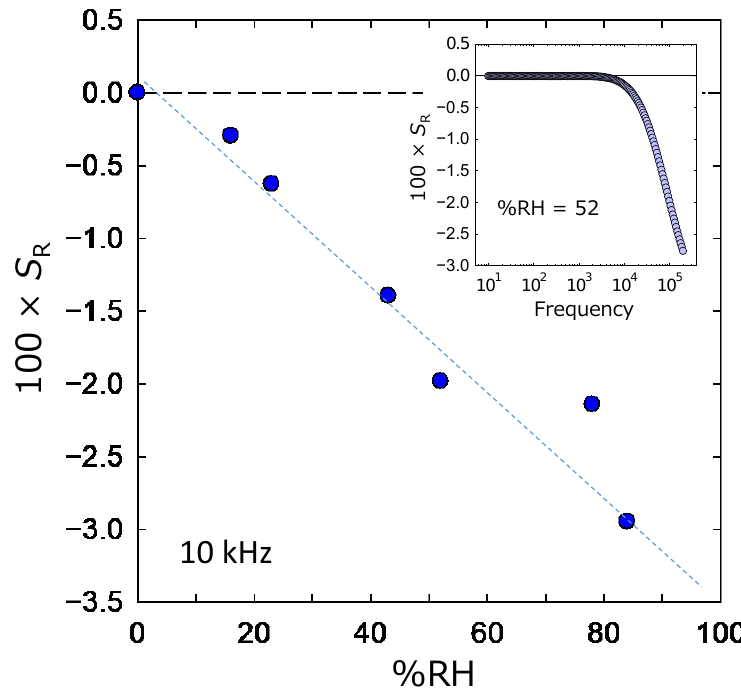
Figure 7. Dependence of the S R on the %RH in the atmosphere of the ZnAl 2 O 4 /Al device. The inserted figure plots the S R values at %RH = 52 against the applied AC frequency.